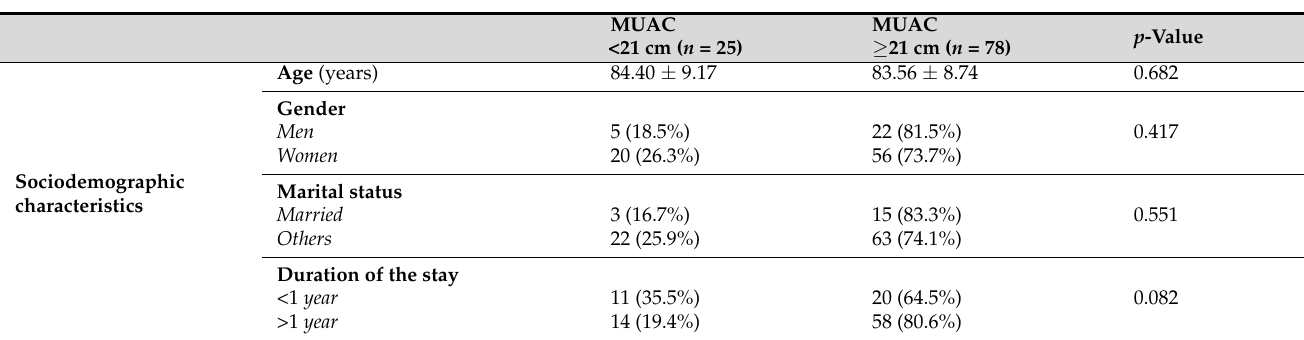
Table 2. Univariate analyses of independent variables associated with